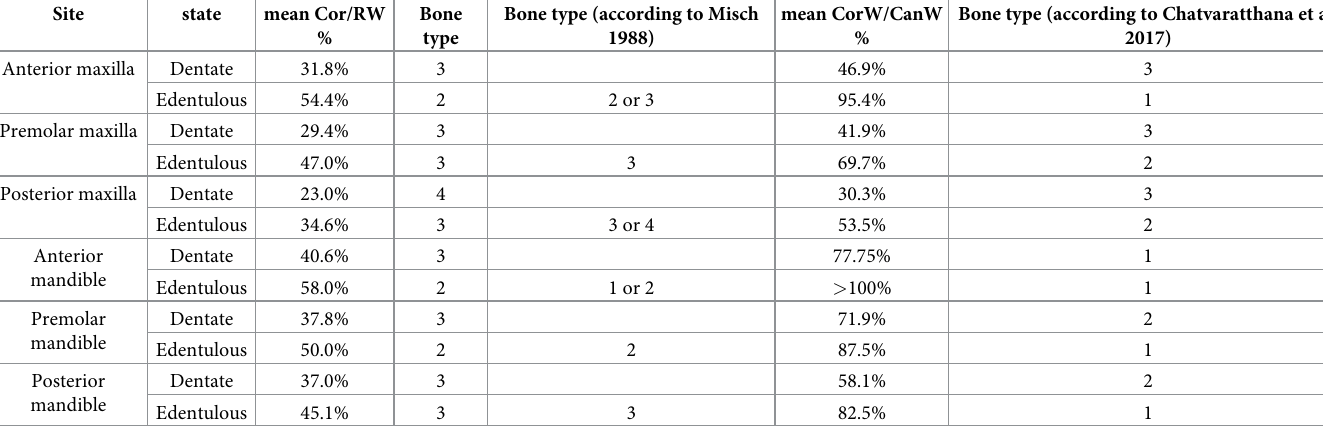
Table 3. Bone types